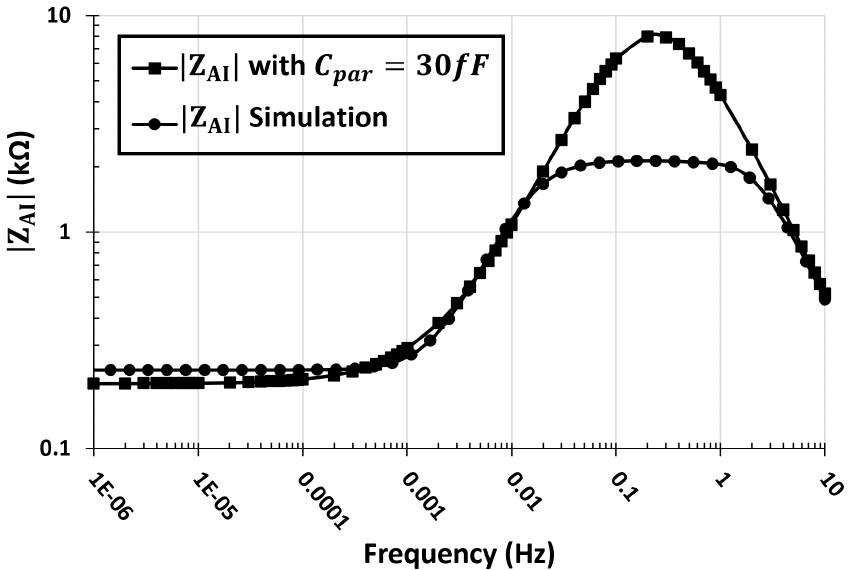
Figure 4. Mathematical model of Z AI looking into the active-inductor with R S included and C par of 30fF along with circuit simulation